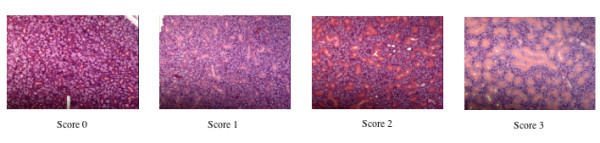
Representative photos of the androgen phenotype scoring points. The picture shows representative photos of the scorings (0–3) used to evaluate the degree of androgen phenotype in eosin-hematoxylin stained SMG sections. The degree of the androgen phenotype in the SMG sections were scored from 0 = no androgen phenotype, to 3 = maximal androgen phenotype.